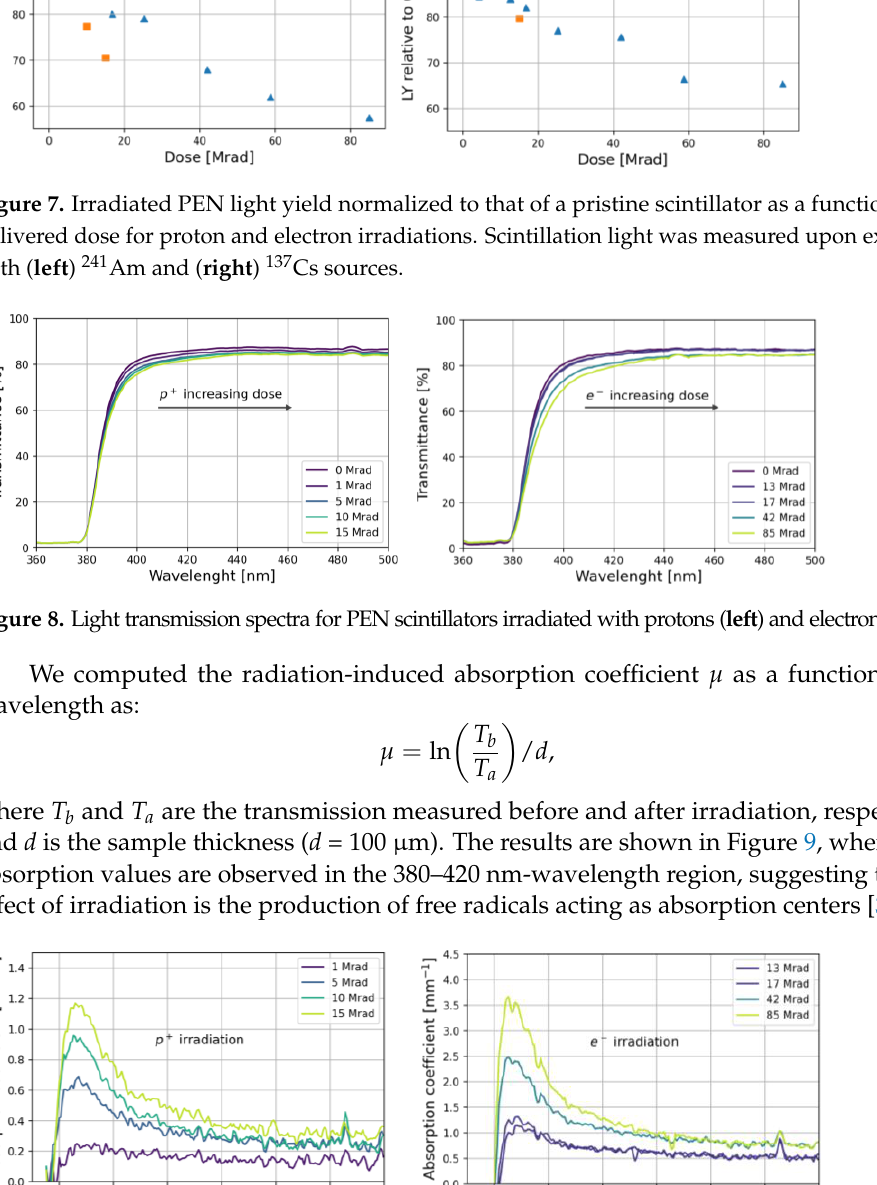
Figure 9. Radiation-induced absorption coefficient spectra for samples irradiated with protons ( left ) and electrons ( right ).